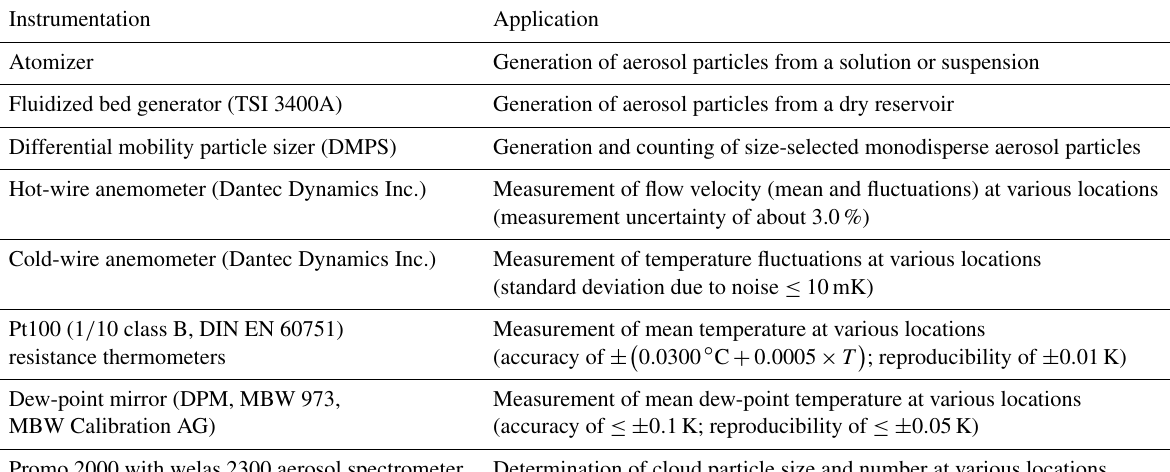
Table 1. Available instrumentation for the generation of defined aerosol particles, for the determination of the respective flow, air and dew- point temperature as well as for measuring cloud particle sizes and numbers inside the measurement